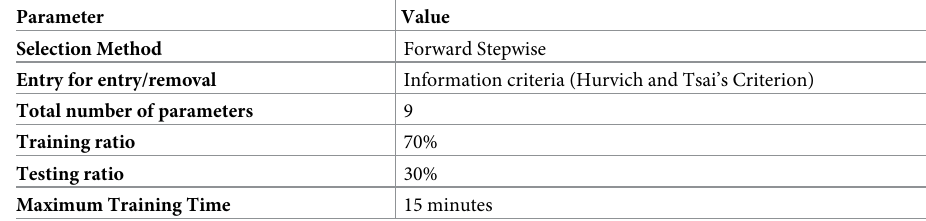
Table 6. Parameters for linear